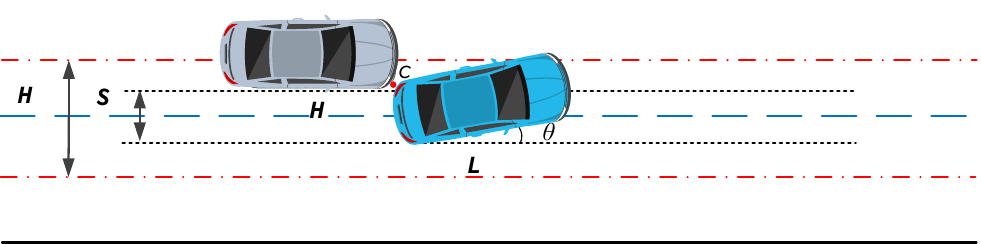
Figure 12. The position of the cut-in vehicle L and the subject vehicle H. The lateral acceleration of the subject vehicle H is 0 and the lateral position is stant. Assuming that the moment at the collision point c is